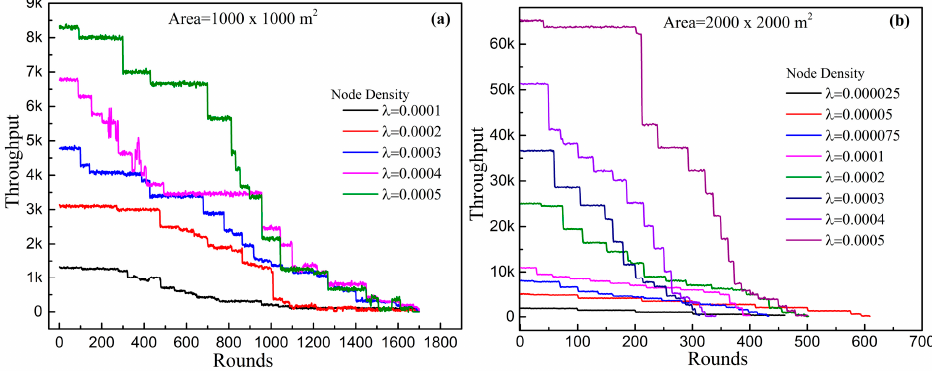
Figure 11. Variation of throughput for different node density in ( a ) 1000 m × 1000 m, and ( b ) 2000 m × 2000 m area.